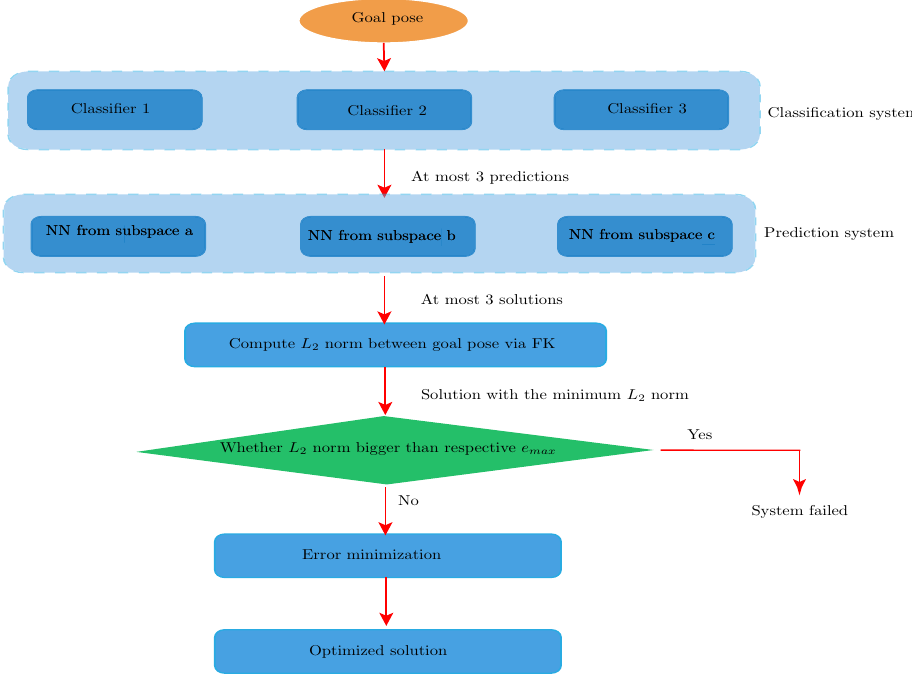
Fig. 3 Workflow of the proposed IKP